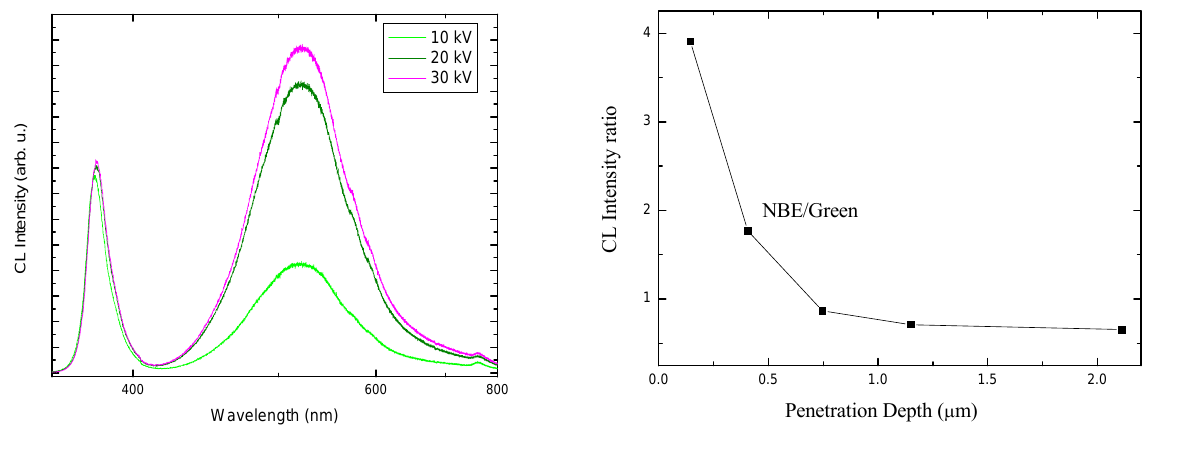
Figure 6. (left) Depth-dependent cathodoluminescence (CL) spectra of ZnO NRs, taken with a spot size of 50 nm at room temperature, at different accelerating voltages and a constant current of 56 pA. (right) The emission intensity ratio of the near band edge and green bands as a function of penetration